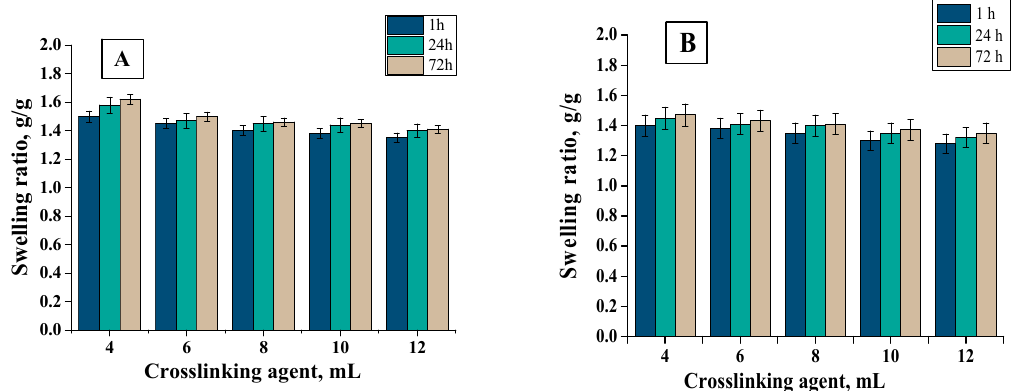
Figure 9. Swelling of materials with di ff erent crosslinking agent PEGDA 575 in ( A ) distilled water (average value SD = 1.12%, number of repetitions n = 3), ( B ) hemoglobin (average value SD = 1.14%, number of repetitions n = 3).